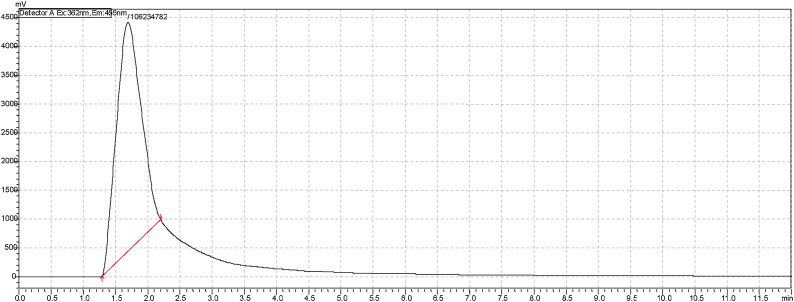
Illustration of a chromatogram of AFB1 non-contaminated dairy cattle feed sample at 20 ul injection on high performance liquid chromatography coupled with RF detector and KobrA cell.